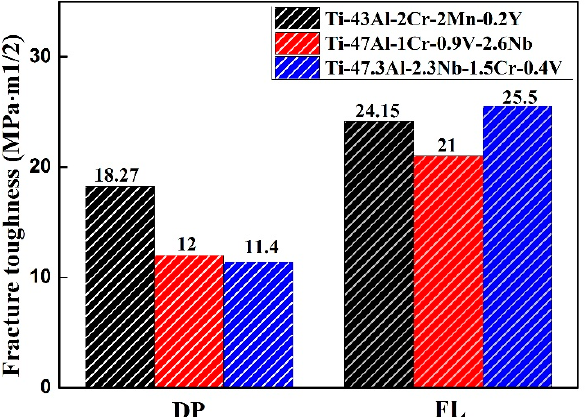
Figure 9. Fracture toughness of various TiAl alloys [25,36].